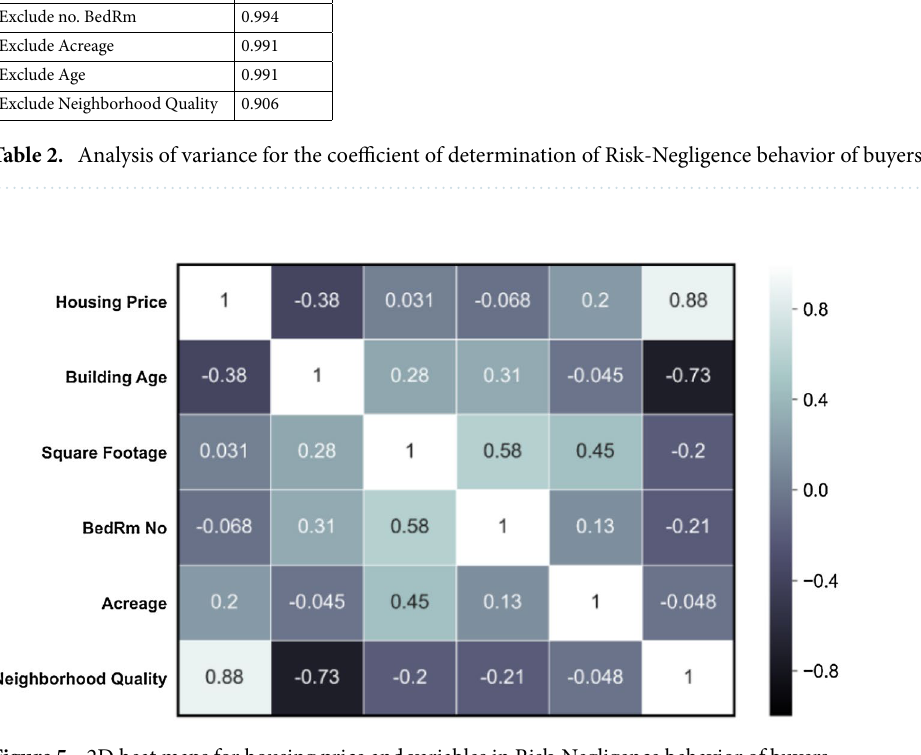
Figure 5. 2D heat maps for housing price and variables in Risk-Negligence behavior of